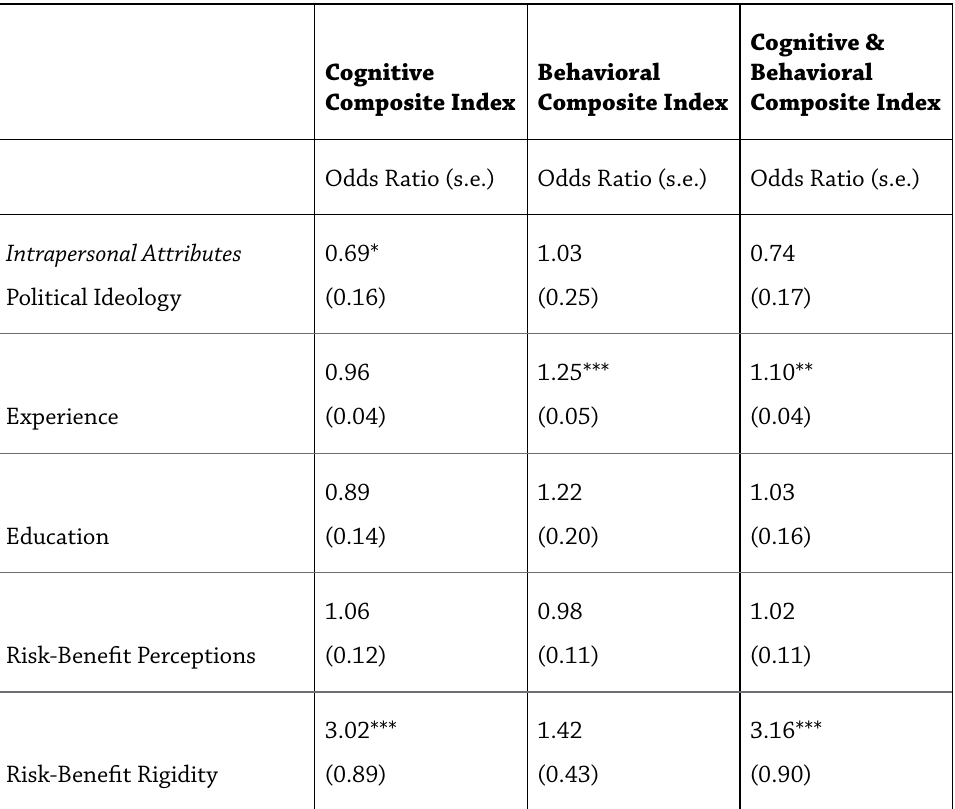
Table 2. Ordered Logit Models for Cognitive, Behavioral and Combined Indexes